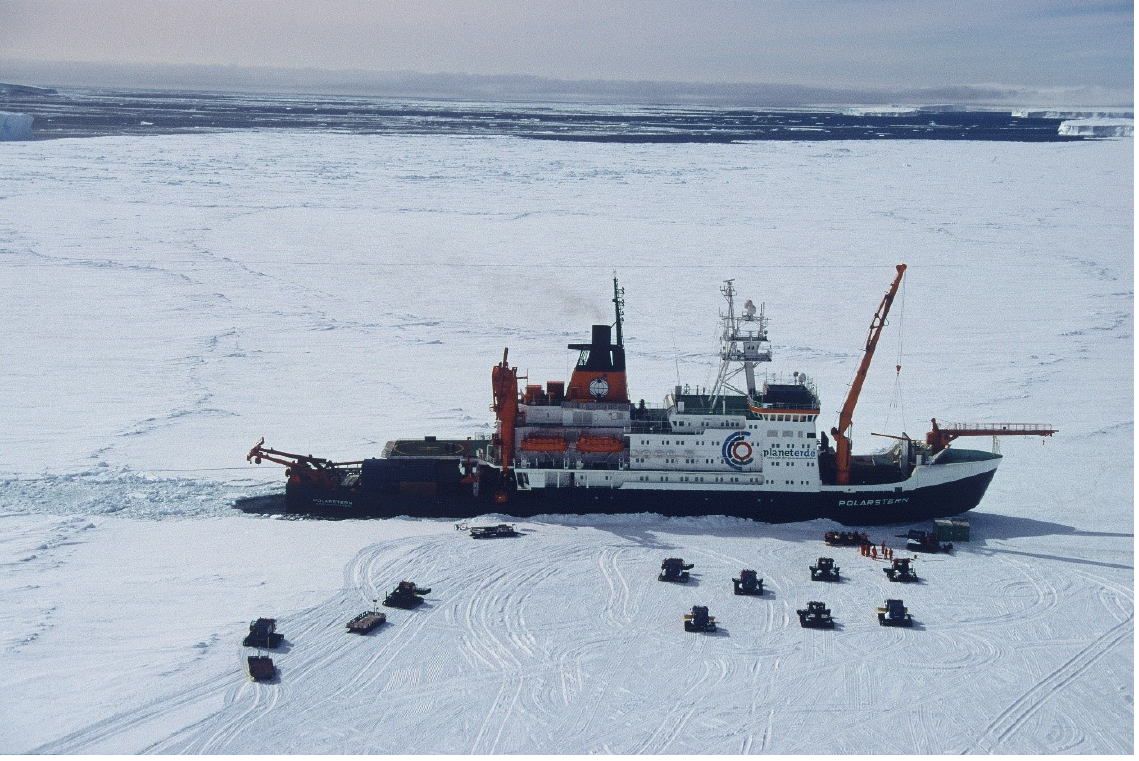
Figure 5: Polarstern in the Atka Bay, Weddell Sea, Antarctica suppling Neumayer Station III. Photo: AWI / H. Grobe